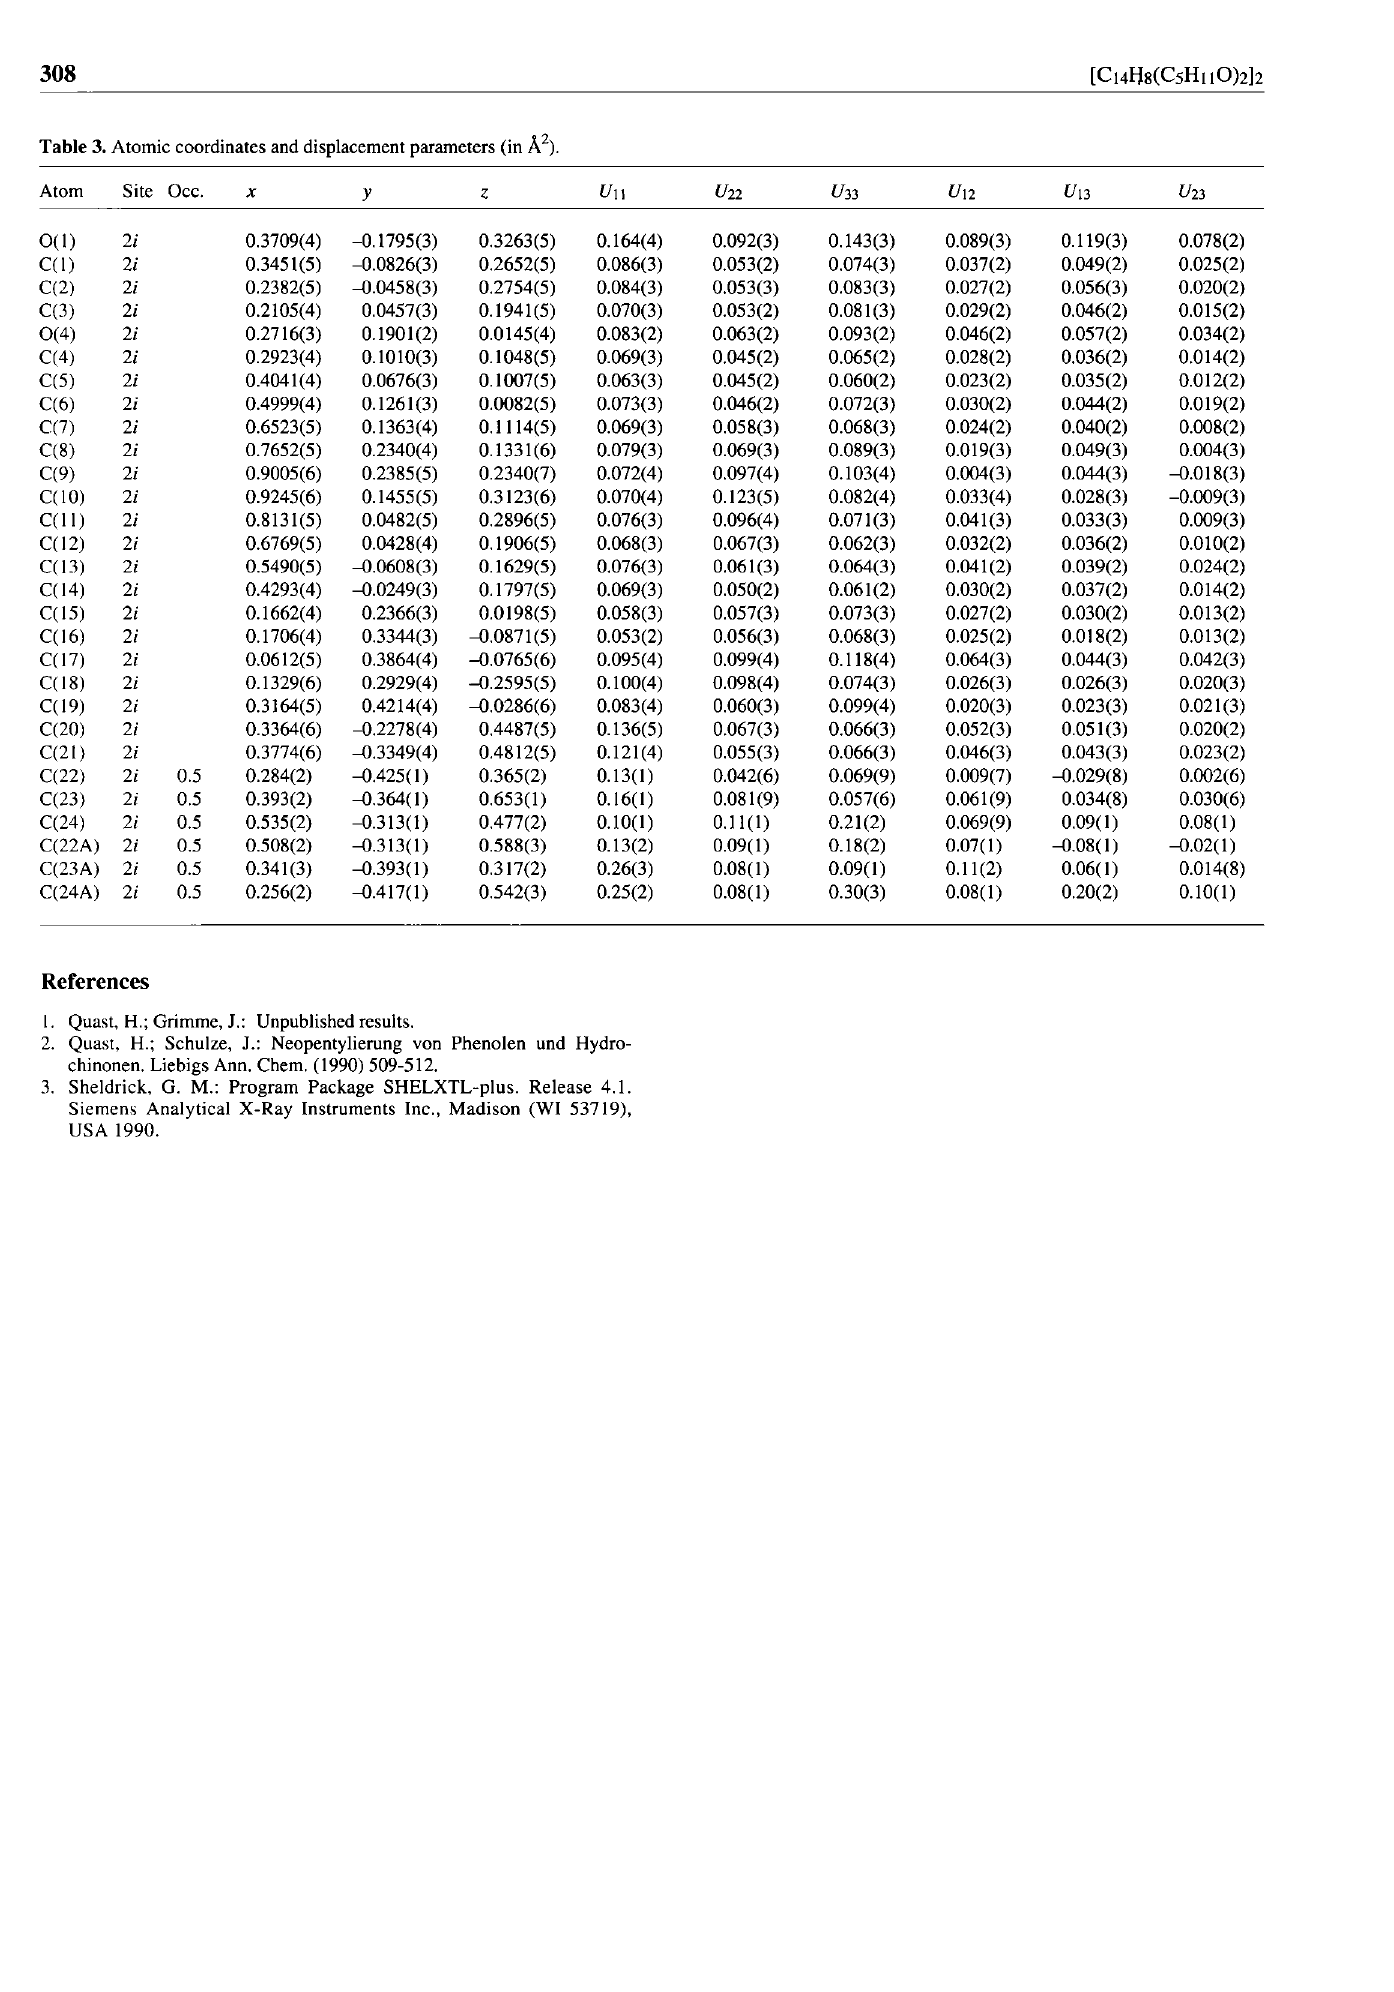
Table 3. Atomic coordinates and displacement parameters (in Ä 2